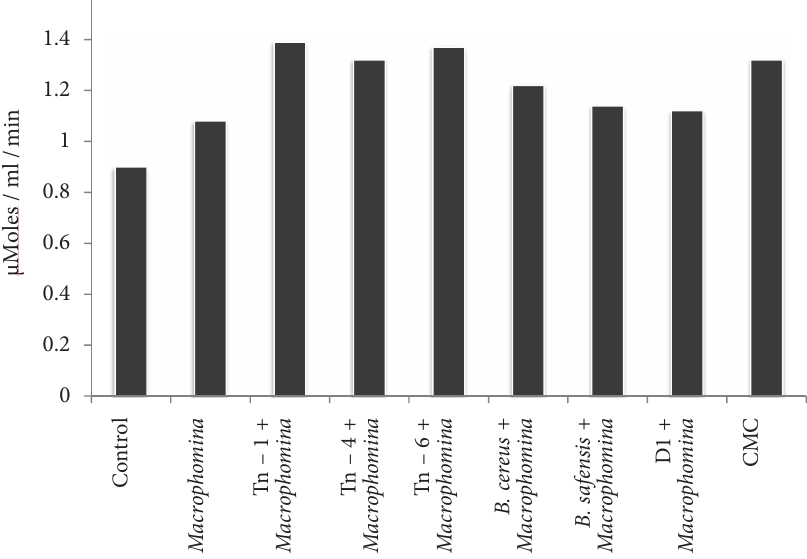
Figure 8. Graphical representation of polyphenol oxidase (PPO) activity in rhizobacteria treated plant